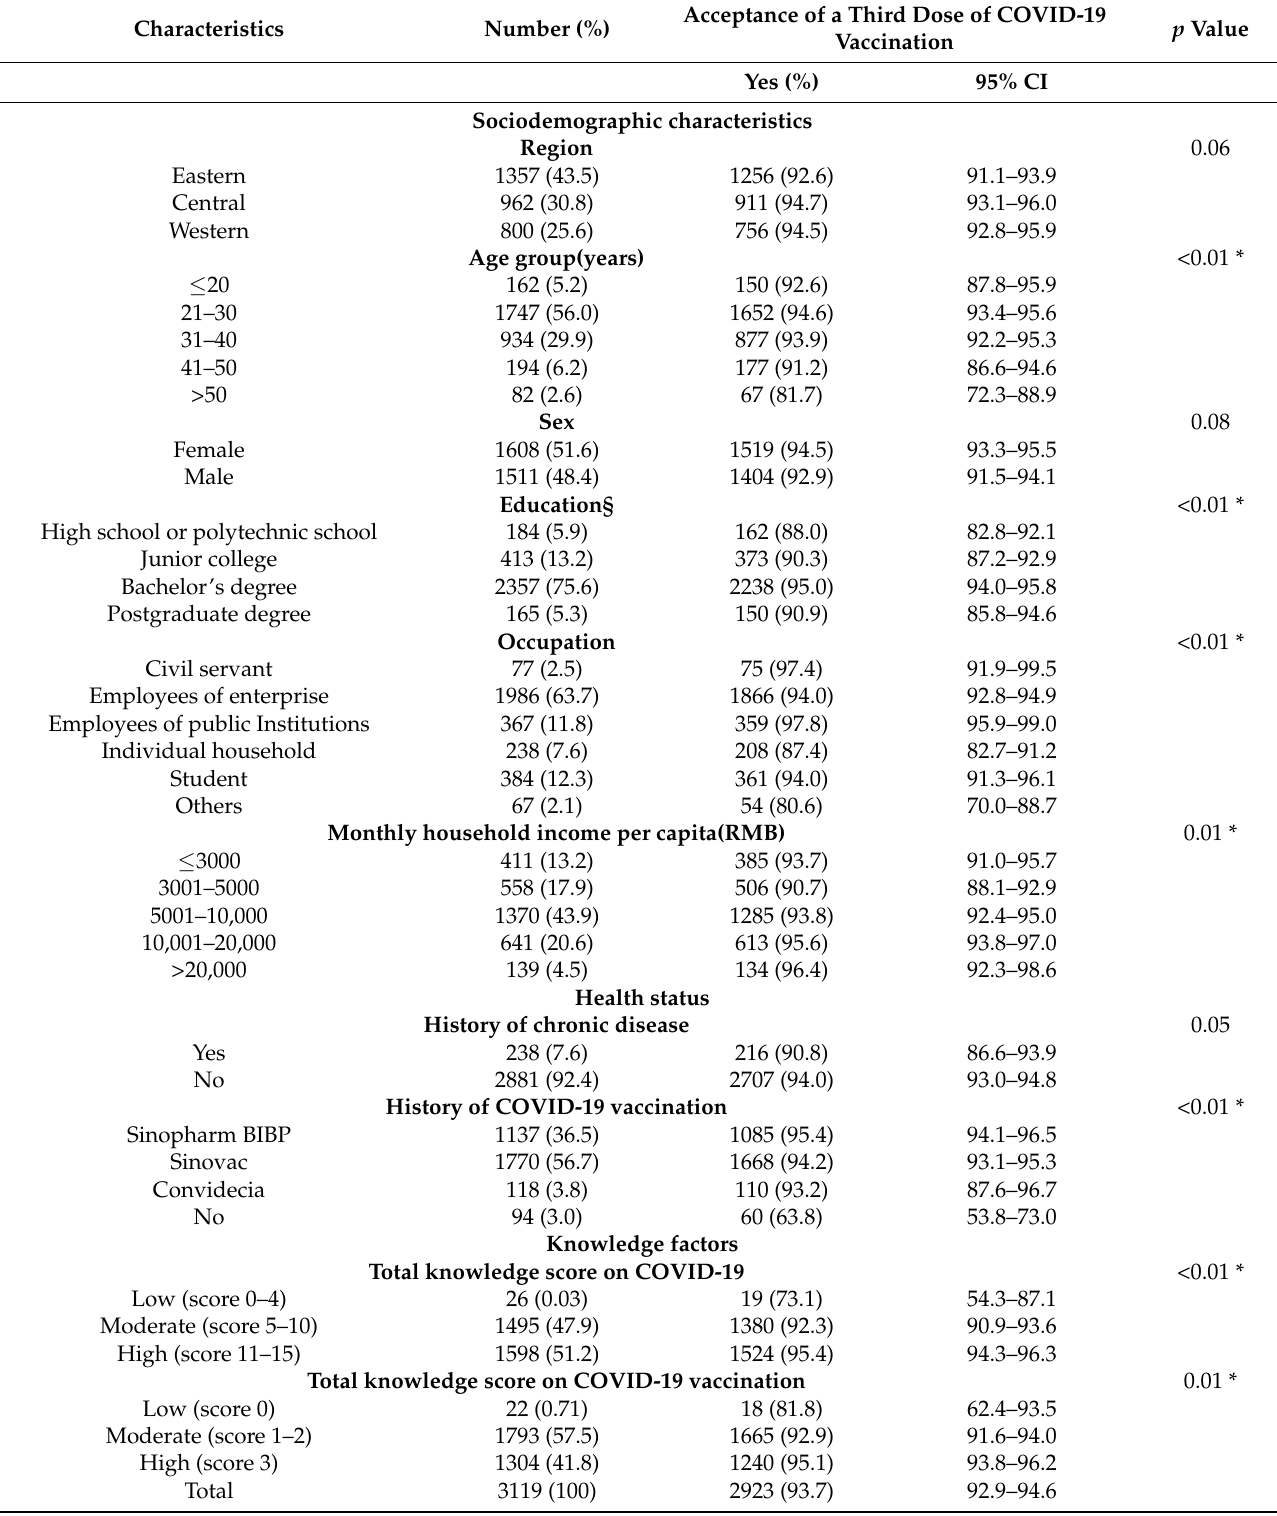
Table 1. Acceptance of a third dose of COVID-19 vaccine in China by demographic characteristics (n =